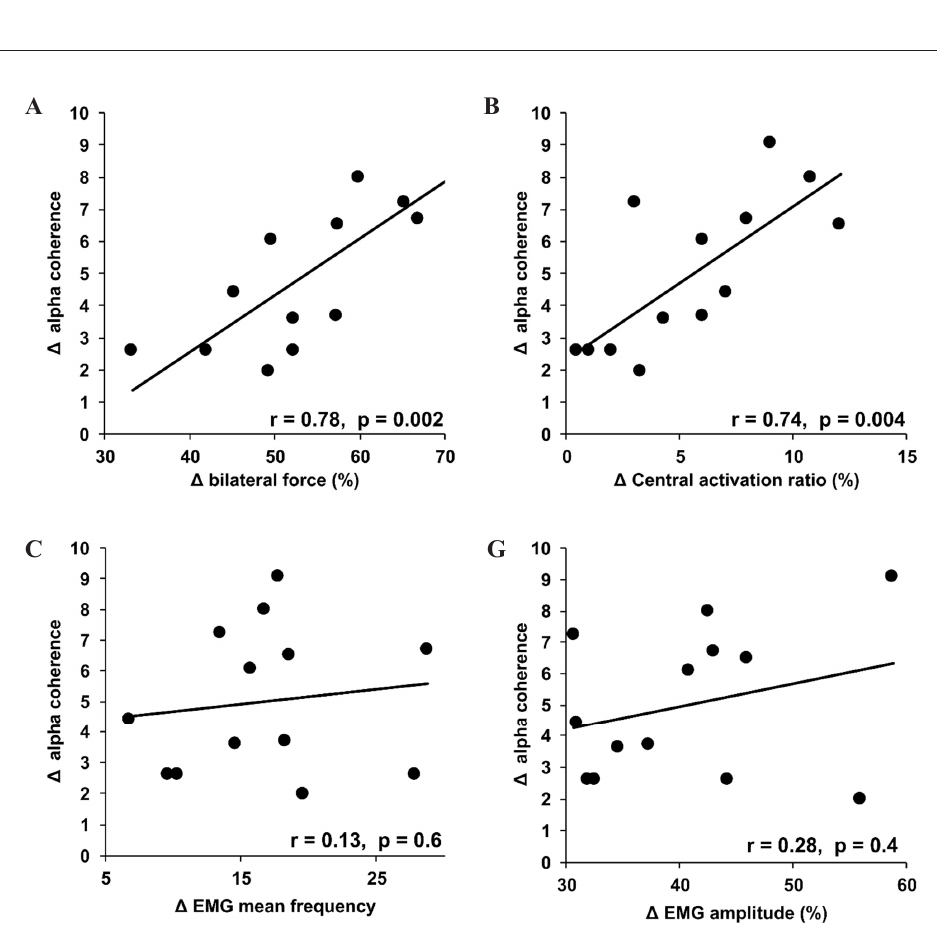
Figure 3. Correlations between changes in EMG-EMG alpha band (8-15 Hz) coherence of homologous vastus lateralis muscles and changes in bilateral force (A), central activation ratio (B), EMG frequency (C) and EMG amplitude (D)